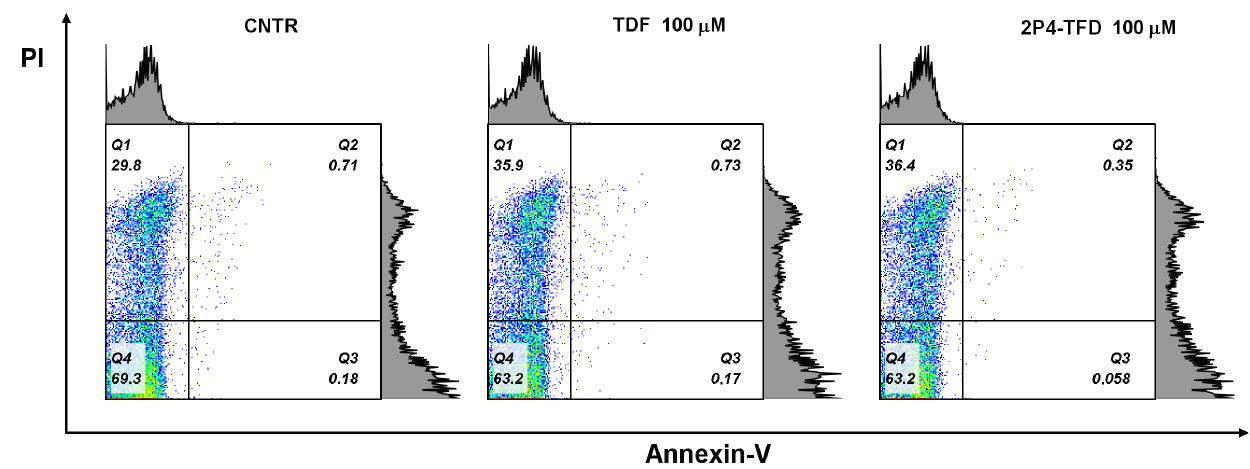
Figure 3. Study of compound-induced apoptosis and necrosis. Peripheral blood mononuclear cells (PBMC) were treated with the compounds (100 μ M) for 24 h. Then, the cells were stained with the mixed anti-CD3/Annexin-V/PI and analyzed by flow cytometry. Representative profiles of apoptosis and necrosis are shown for the CD3 + cell population. Quadrants: living cells (Q4, Annexin V − /PI − ), early apoptosis (Q3, Annexin V+/PI − ), late apoptosis (Q2, Annexin V+/PI+), and necrosis (Q1, Annexin V − /PI +).